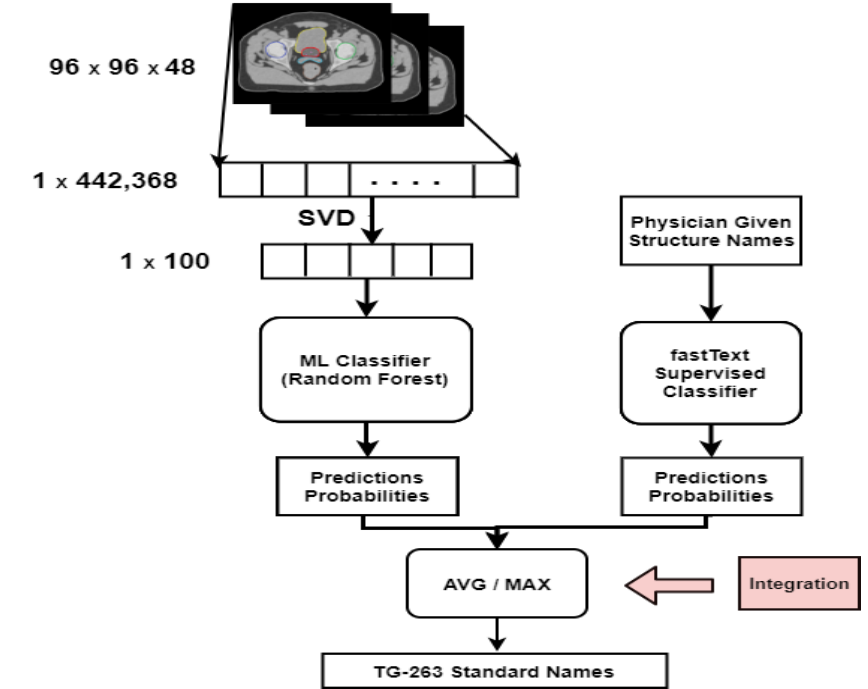
Figure 2. Late integration architecture for structure name